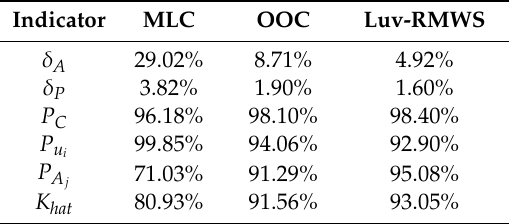
Table 4. Evaluation of accuracy of unstable slope boundary extraction from experimental